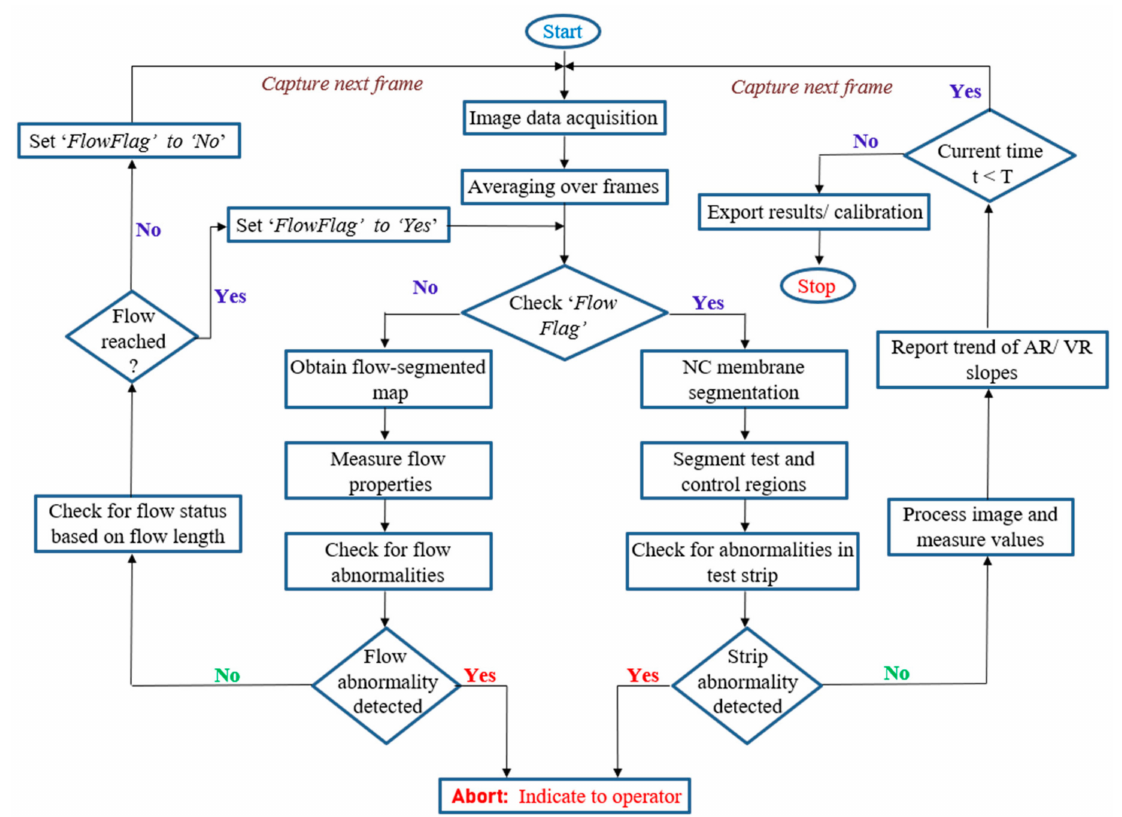
Figure 3. Flowchart of the designed algorithm indicating the steps involved in the algorithm execution. Flow progress within the NC membrane is determined by segmenting out the flow region of the captured image. Here, the concept of global thresholding is adapted, wherein pixel values of the input image I(t) greater than the set threshold intensity (T) are assigned a binary ‘1’ value, and the rest are mapped to binary ‘0’ as indicated [21].